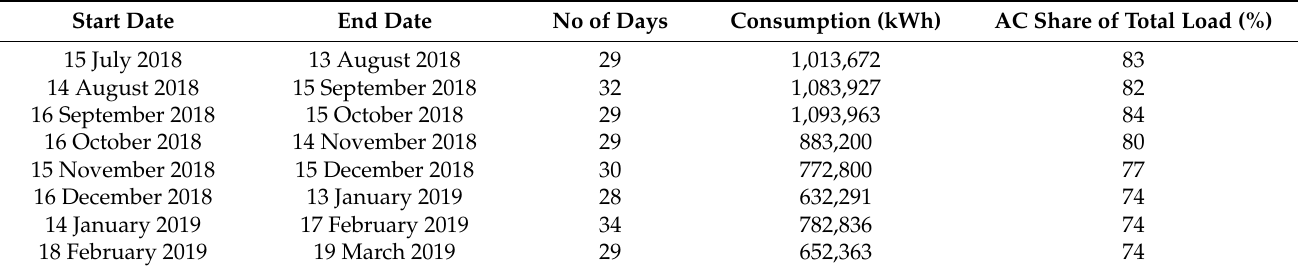
Table 1. Consumption and share of non-AC loads for